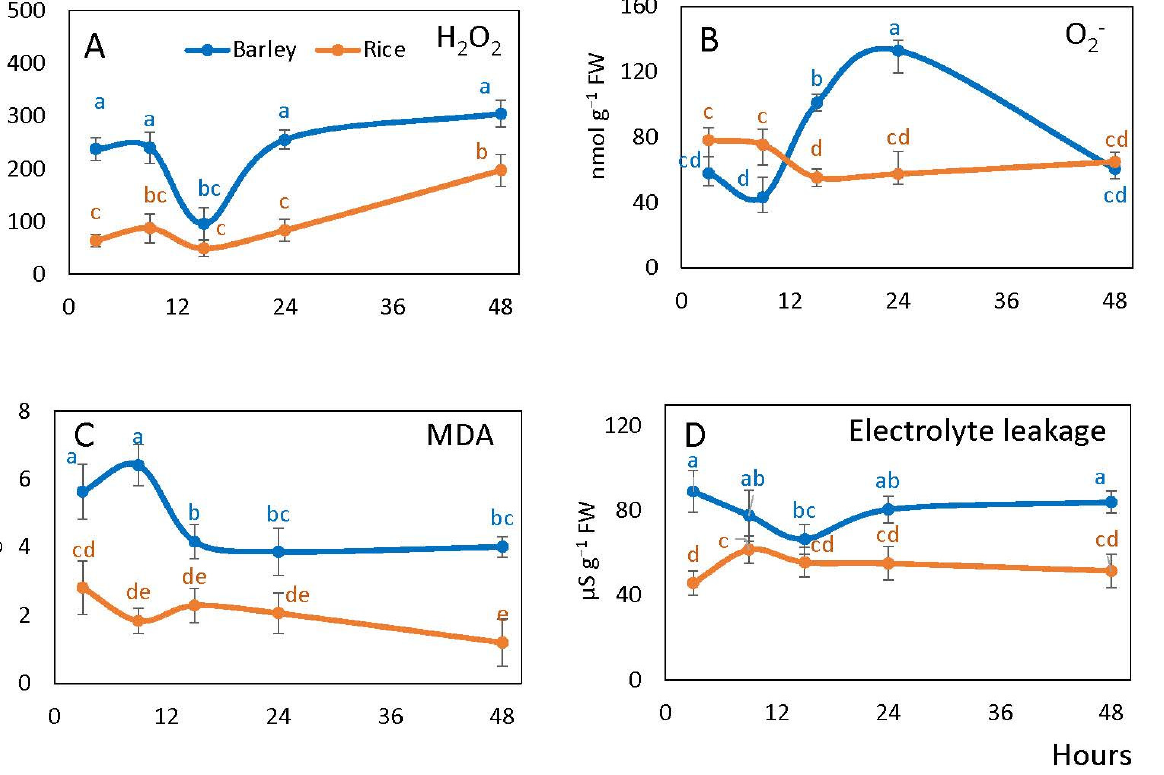
Figure 4. Barley and rice seed embryonic hydrogen peroxide (H 2 O 2 ) ( A ), superoxide anion ( B ), lipid peroxidation in terms of MDA ( C ) and seed electrolyte leakage ( D ) following imbibition. Vertical bars represent standard deviations ( n = 3). Different letters indicate significant differences between the two species and the time points at p < 0.05, (one-way ANOVA test, Tukey comparison).